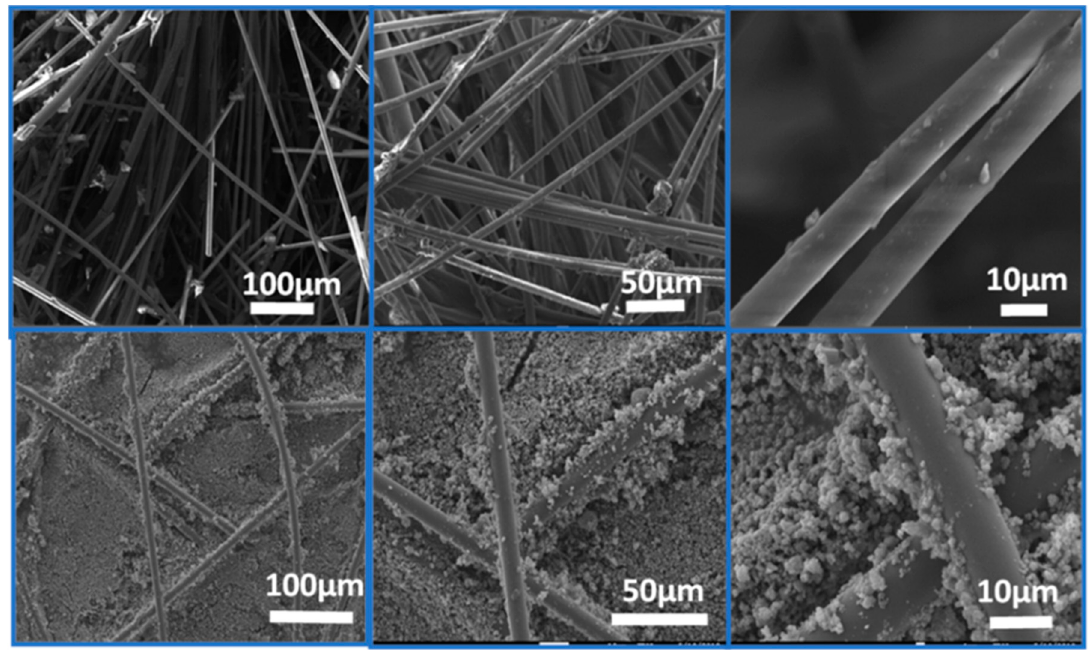
Figure 1. Scanning-electron micrographs of pure fabrics (top row) and photocatalyst-coated fabrics (bottom row).